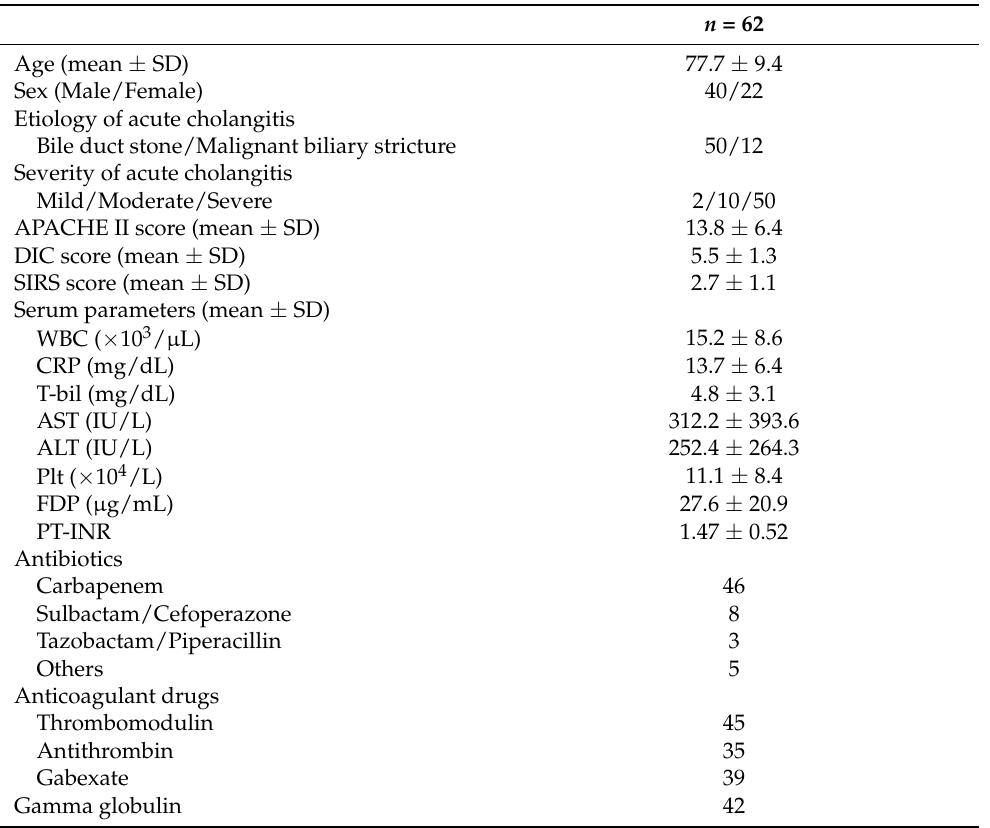
Table 2. Patient backgrounds.